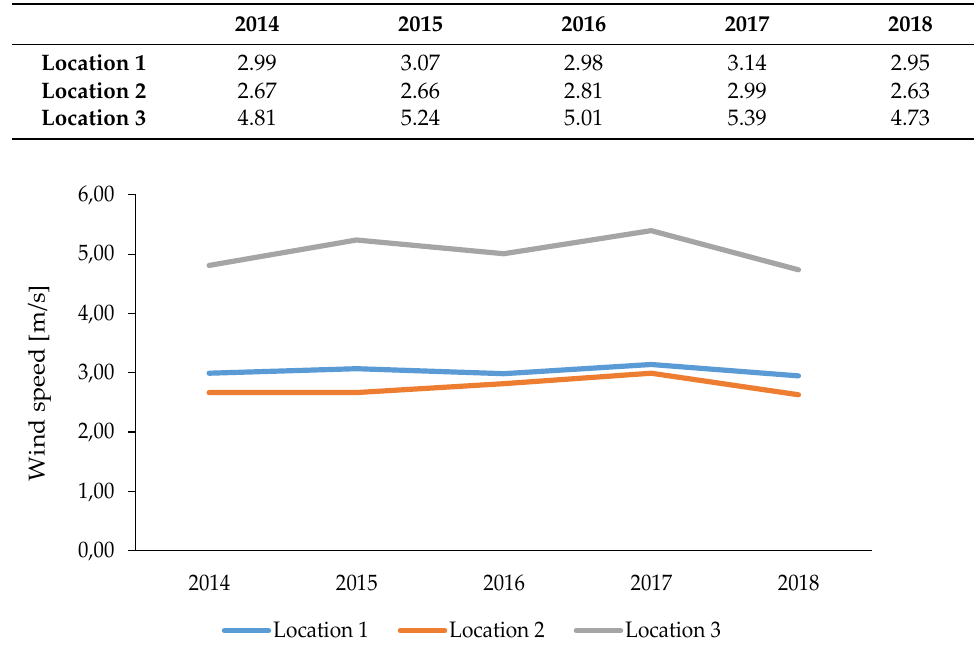
Figure 9. Wind frequency distribution at each location in 2018. Table 3. Average wind speeds (m/s) at the tested locations between 2014 and 2018.